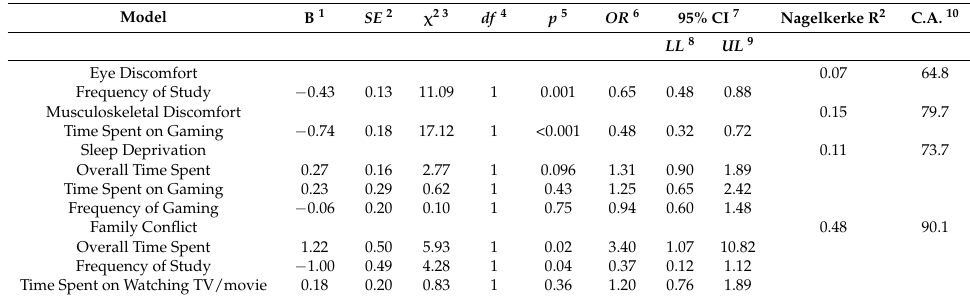
Table 7. Complex sample binary logistic regression estimating likelihood of perceived outcomes among primary school students.